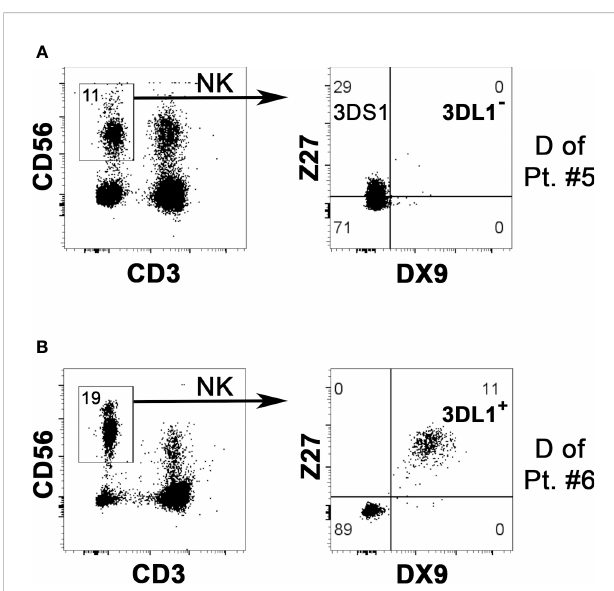
FIGURE 1 Evaluation of KIR3DL1 NK surface expression to con fi rm possible NK alloreactivity in case of HLA-Bw4 mismatch. By fl ow-cytometry, NK cells (gating on CD3 – CD56 + cells of PBMC, left panels) from two potential Allo Bw4 donors were analyzed using DX9 (anti-KIR3DL1) and Z27 (anti-KIR3DL1/S1) mAbs to detect the surface expression of KIR3DL1 (i.e., the relevant iKIR speci fi c for HLA-Bw4) and/or KIR3DS1 (right panels). The “ KIR ” acronym has been omitted in the receptors identi fi ed within the quadrants. (A) NK cells from donor of patient #5 did not express KIR3DL1 (DX9 – ), while KIR3DS1 (Z27 + /DX9 − ) was present. This donor couldn ’ t be considered as NK alloreactive. (B) a portion of NK cells from the donor of patient #6 expressed KIR3DL1 (Z27 + /DX9 + ), con fi rming the NK